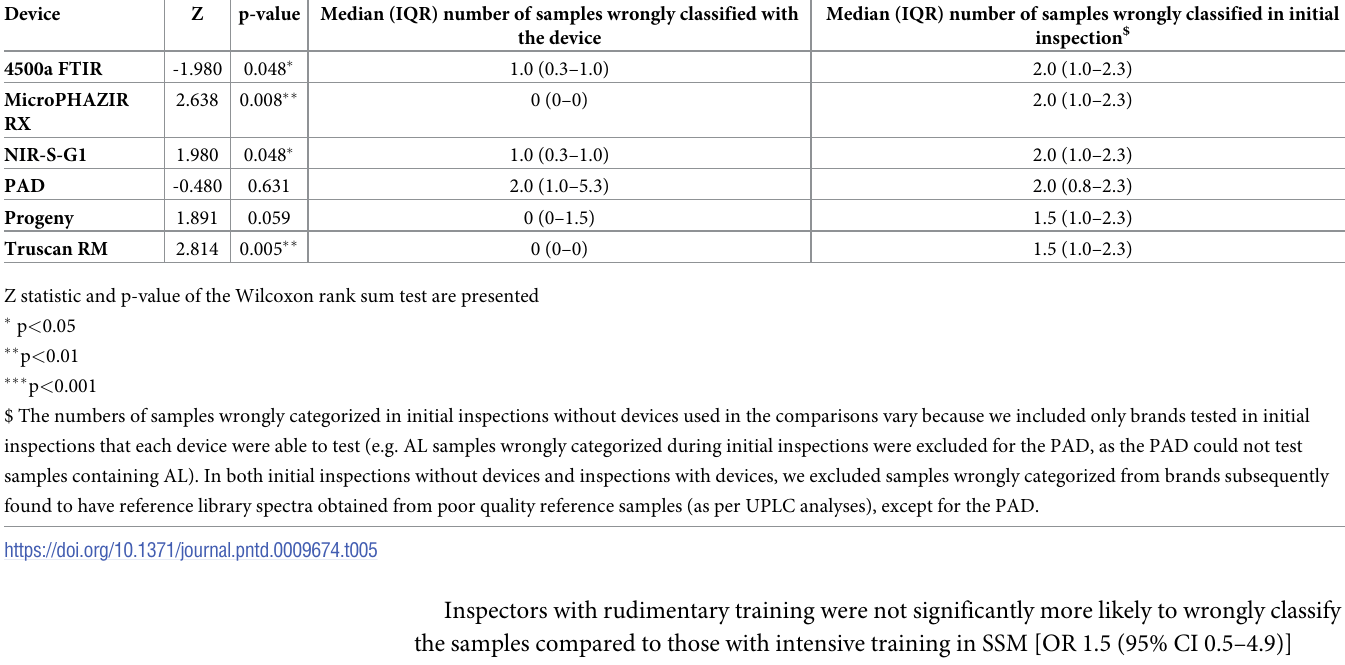
Table 5. Comparison of the number of samples incorrectly classified in evaluation pharmacy inspections with devices vs initial visual inspection without device.